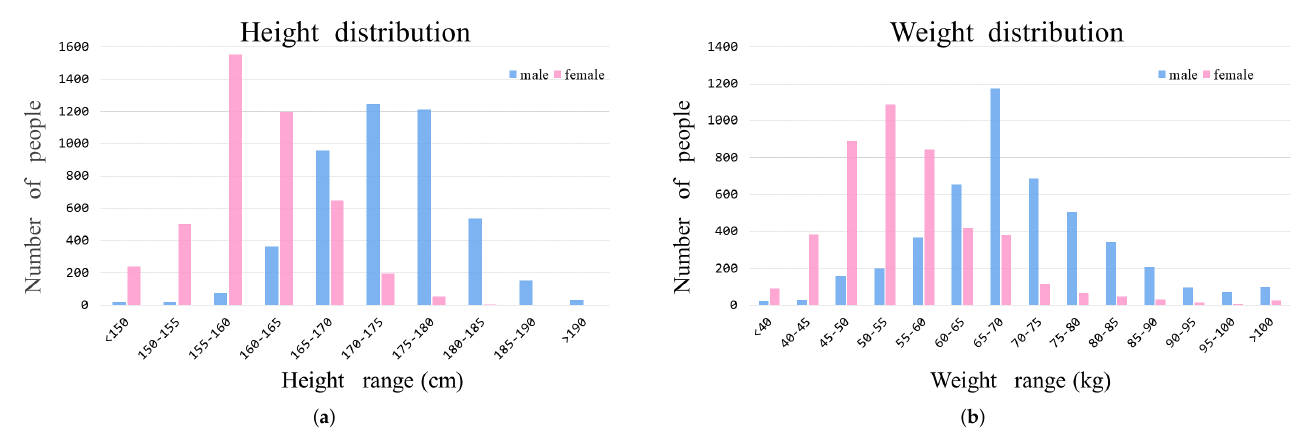
Figure 2. Human body contour keypoints for front-view images ( a ) and side-view images ( b ).